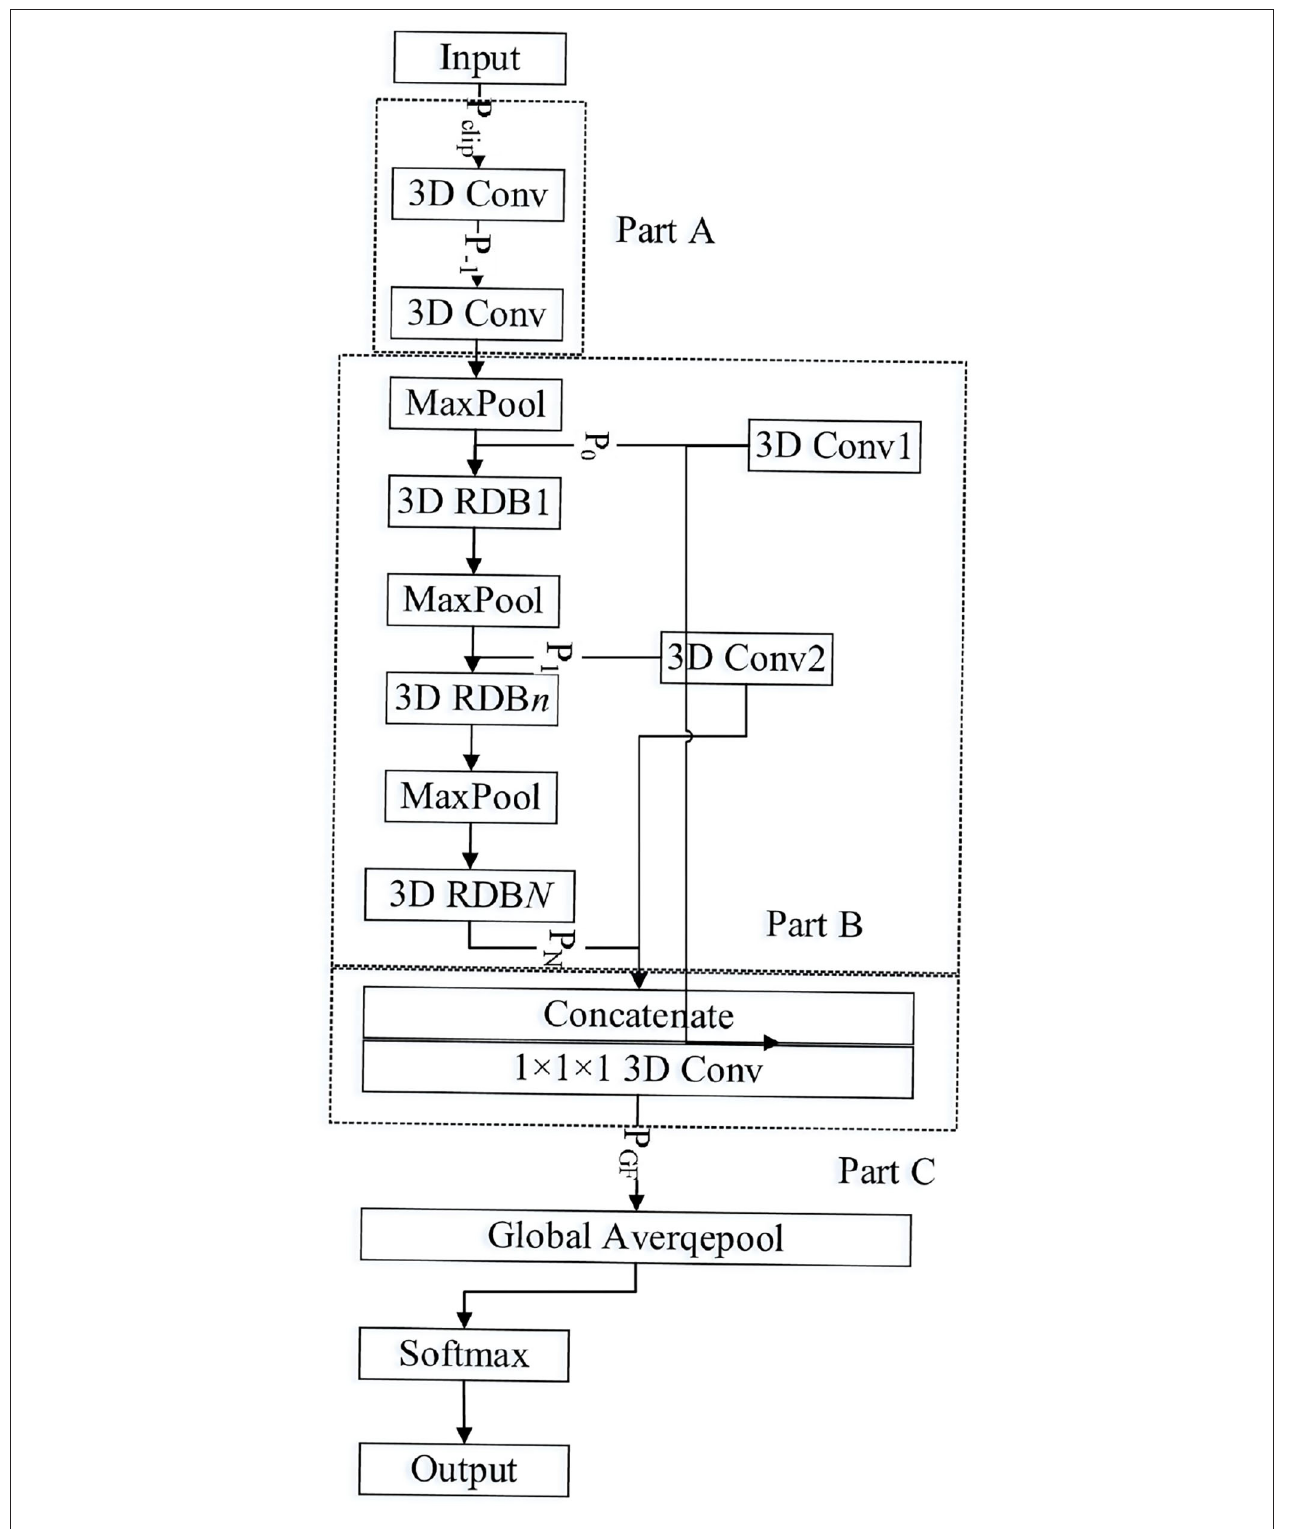
FIGURE 1 | 3D multiscale dense residual